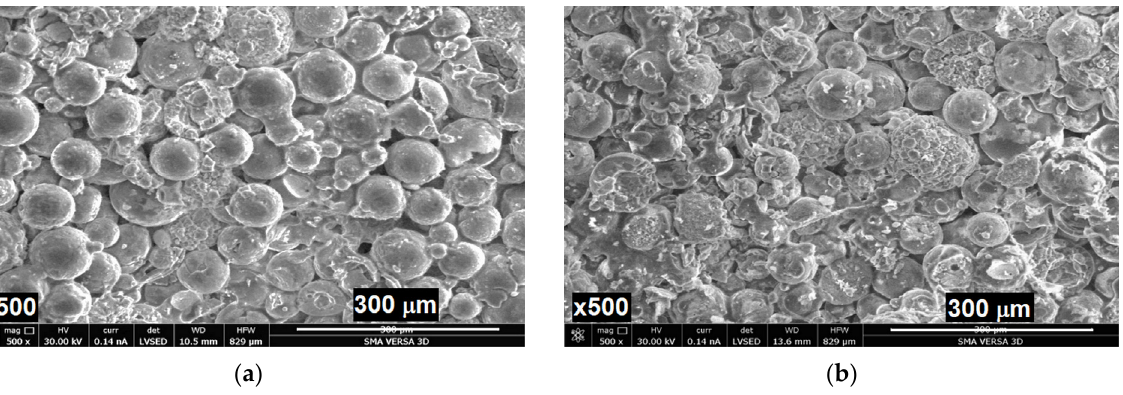
Figure 7. SEM images of fracture surfaces of ceramics based on hollow alumina microspheres (HAM) with 15 wt.% of bentonite binder pressed at ( a ) 30 and ( b ) 40 MPa.